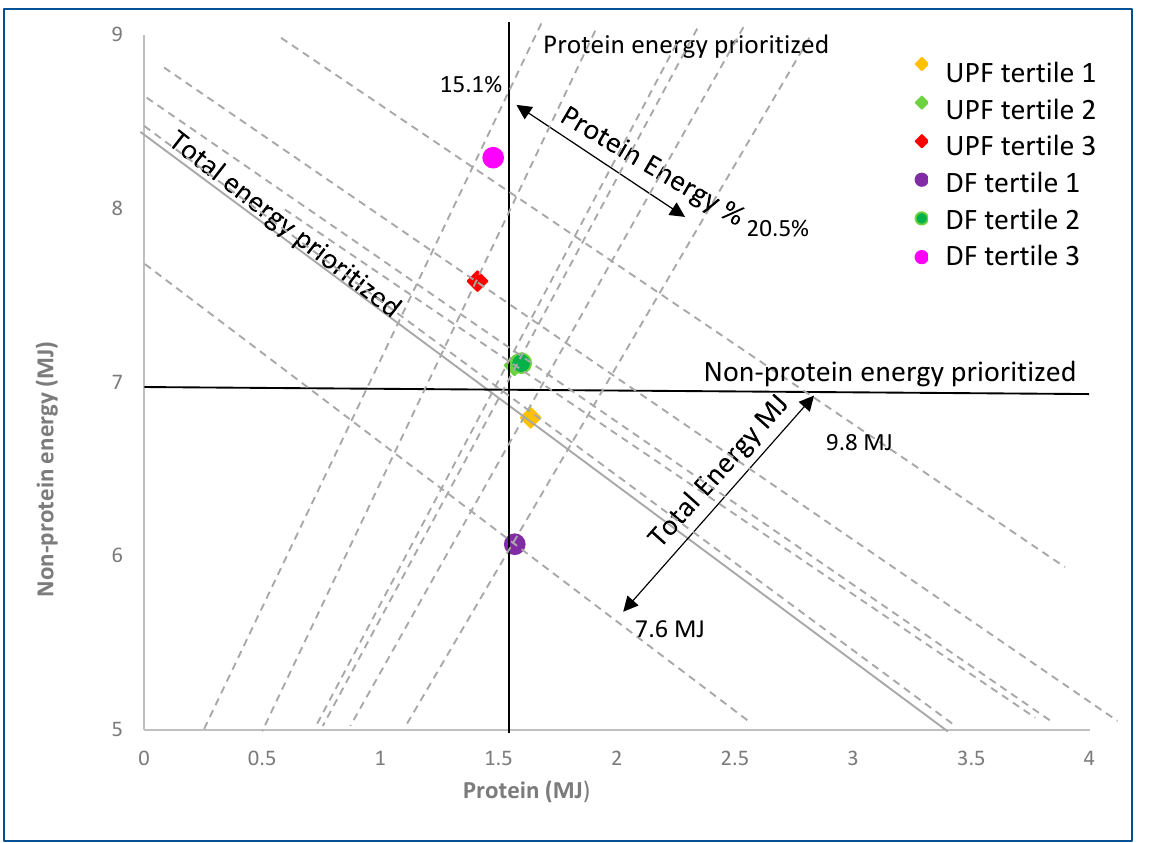
Figure 2. Mean protein and non-protein energy intake for participants categorised into tertiles of discretionary food (DF) and ultra-processed food (UPF). The positively sloped radials indicate the proportion of energy from protein from total energy intake and demonstrate protein dilution with increased intake of discretionary and UPF. The negatively sloped diagonals indicate total daily energy intake. The data points line up along the solid vertical line demonstrating that protein energy intake is prioritised. If total daily energy intake is prioritised, the values line up along the solid negative radial, while the horizontal line indicates the situation if non-protein energy is prioritised.